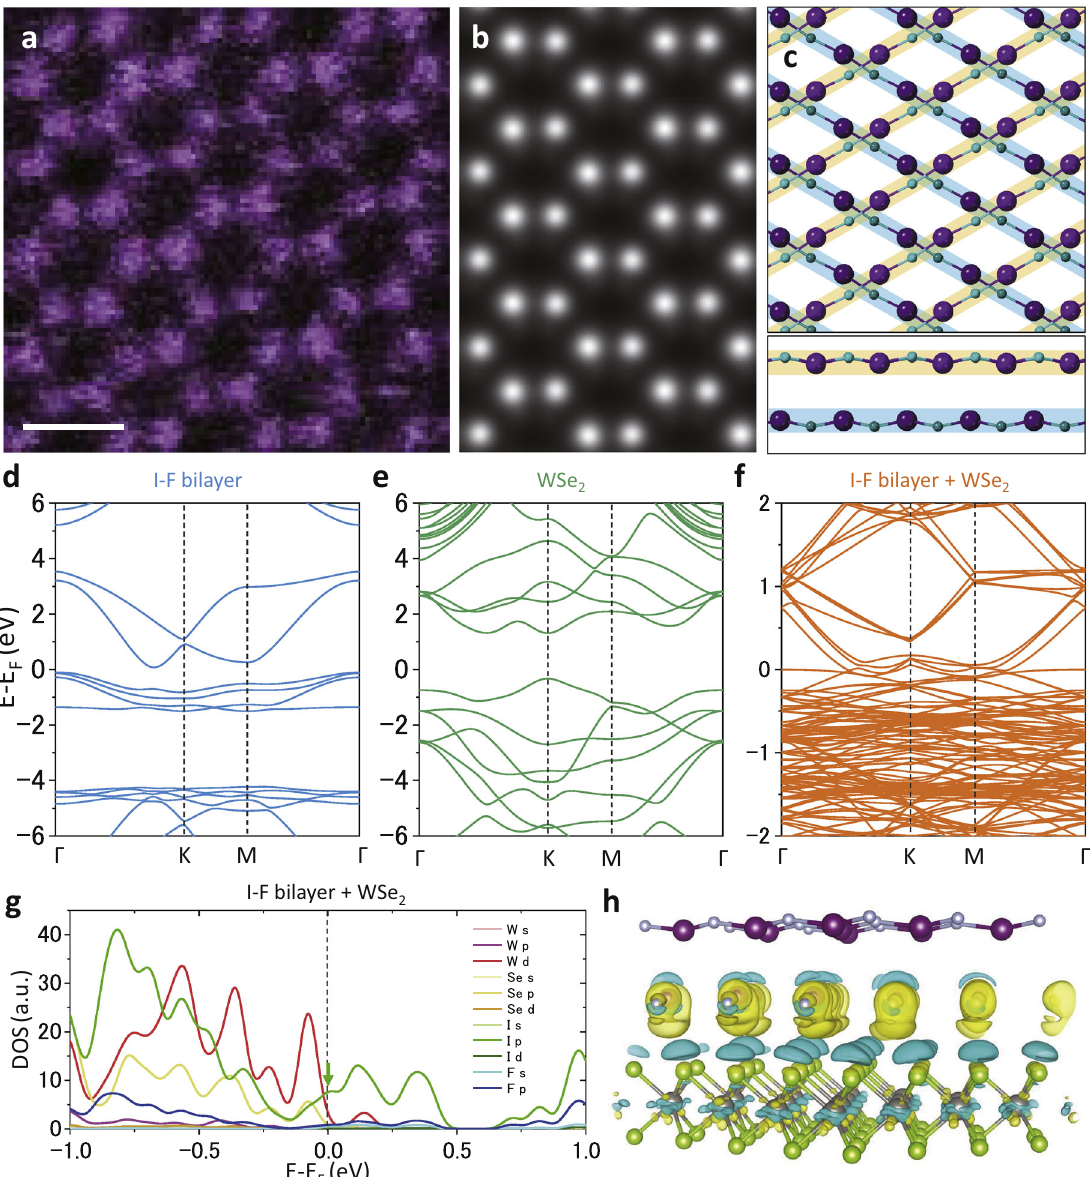
Fig. 4 Theoretical electronic structure of the 2D IF layer on WSe 2 . a A STEM-ADF image of the IF bilayer after the contrast due to the WSe 2 substrate has been removed. Bright atoms correspond to the iodine atoms ( Z = 53). Fluorine atoms are hardly visible because of their smaller atomic number ( Z = 9). The scale bar is 0.5 nm. b The STEM simulation image of the IF bilayer showing an excellent match with the experimentally derived atomic positions of iodine. c The corresponding atomic model of IF bilayer obtained through a DFT calculation. The top and bottom IF layers are colored by orange and blue ribbons, respectively. d – f DFT calculated band structures of free-standing IF bilayer, WSe 2 monolayer, and IF bilayer on WSe 2 substrate. Cusps at K in ( f ) are due to the asymmetric atomic positions of the IF bilayer. g Density of states analysis of IF bilayer on WSe 2 . Se p -states and I p -states (pointed by the green arrow) near the Fermi level contribute to the interaction between the IF bilayer and WSe 2 . The typical coupling between W d - and Se p -states of WSe 2 is also shown just below the Fermi level. h Charge difference analysis of IF bilayer on WSe 2 from separate IF bilayer and WSe 2 . Yellow and cyan colored regions indicate the charge accumulation and depletion, respectively. The isosurface was drawn at 5 × 10 − 4 e Å − 3